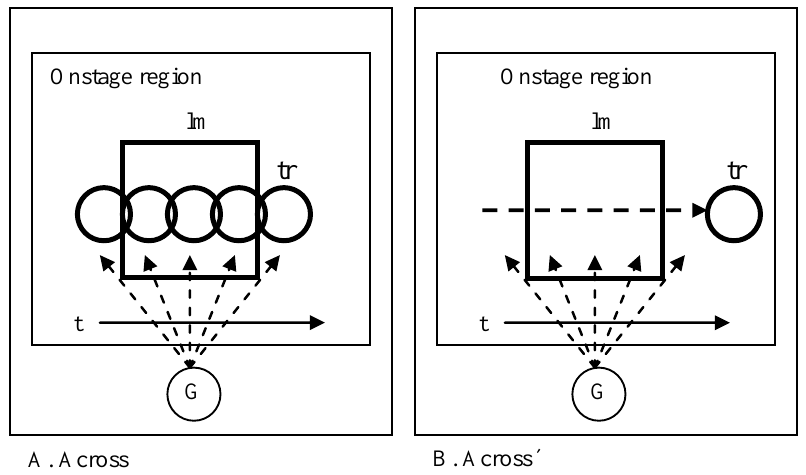
Figure 2. Subjectification of across (cf. Langacker, 2006: